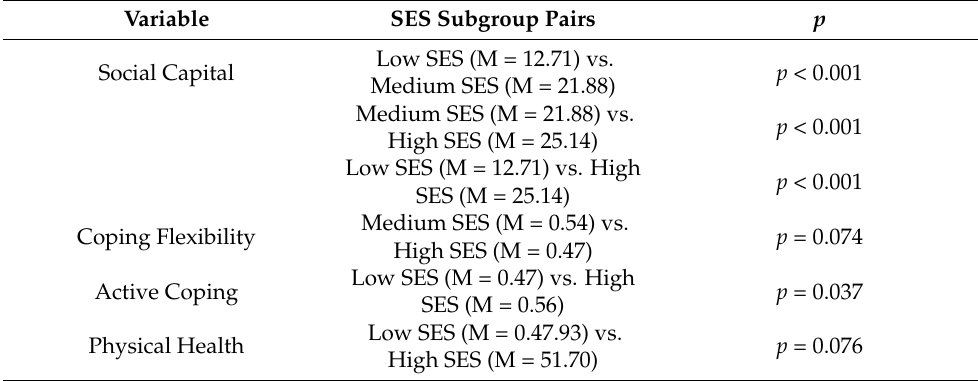
Table 2. Significant results of post hoc Bonferroni test on SES subgroup